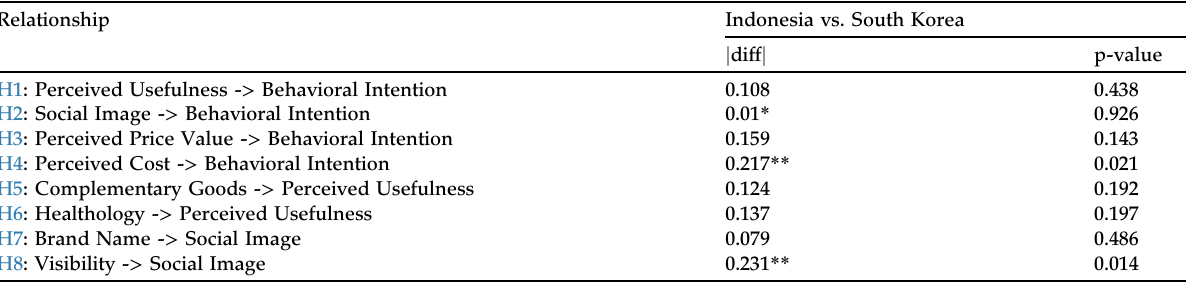
Table 8. Multigroup comparison test results.